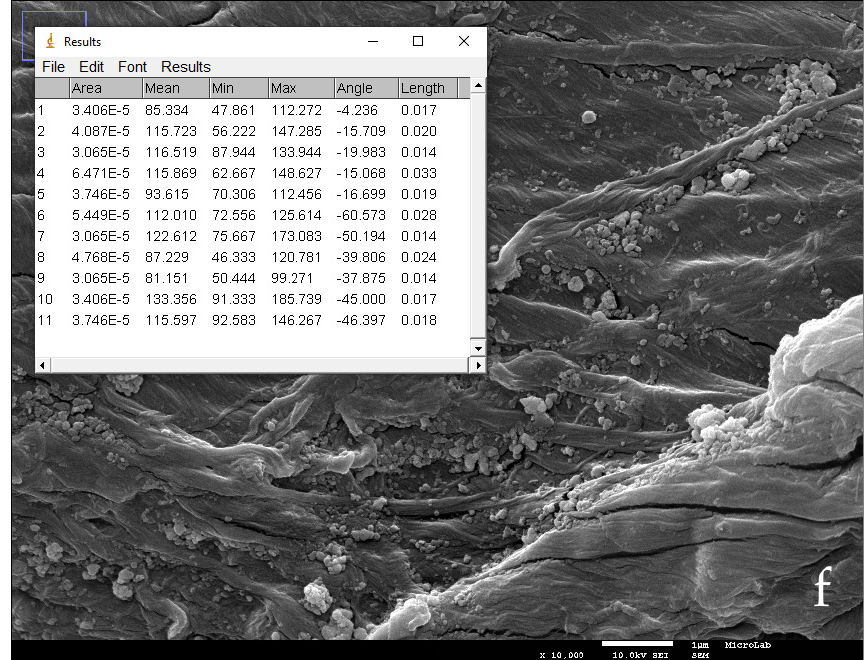
Figure 3. SEM images of melanin and TiO 2 nanoparticles used in this work. ( a – d ), for melanin; ( e , f ) for TiO 2 . Explanation in the text. Measurement bars in microns. Images magnification: ( a ) and ( b )—×5000, ( c ) to ( f )—×10,000.